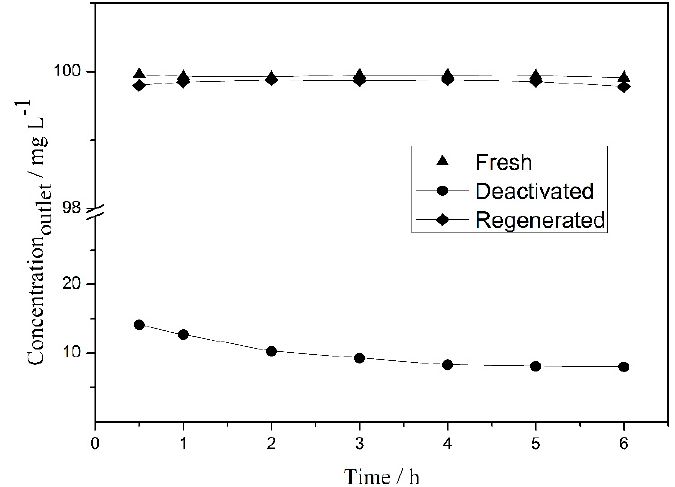
Figure 7. Dechlorination of 4-CP during HDC reaction in fresh, used and deactivated Pd/CNT-Ni foam micro reactors. Reaction conditions: residence time (3 min), Pd loading (0.5 wt.%), FA/substrate molar ratio (5:1), 4-chlorophenol concentration (1 mmol/L).